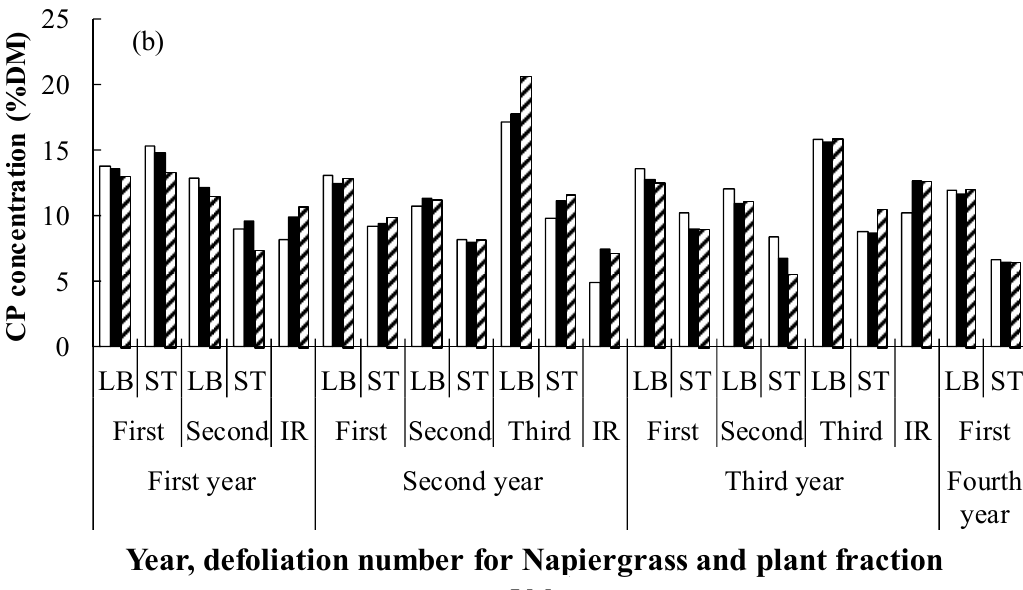
Figure 2. ( a ) In vitro DM digestibility and ( b ) Crude protein (CP) concentration of dwarf genotype of late ‐ heading (DL) Napiergrass and Italian ryegrass (IR), as affected by fertilizer treatments in 2007–2010. Symbols with different letters were significantly different among treatments at each defoliation by the LSD method at the 5% level. NS: not significant at p > 0.05. For abbreviations of treatments and years, refer to Figure 1. Plant fractions: leaf blade (LB), stem inclusive of leaf sheath (ST).